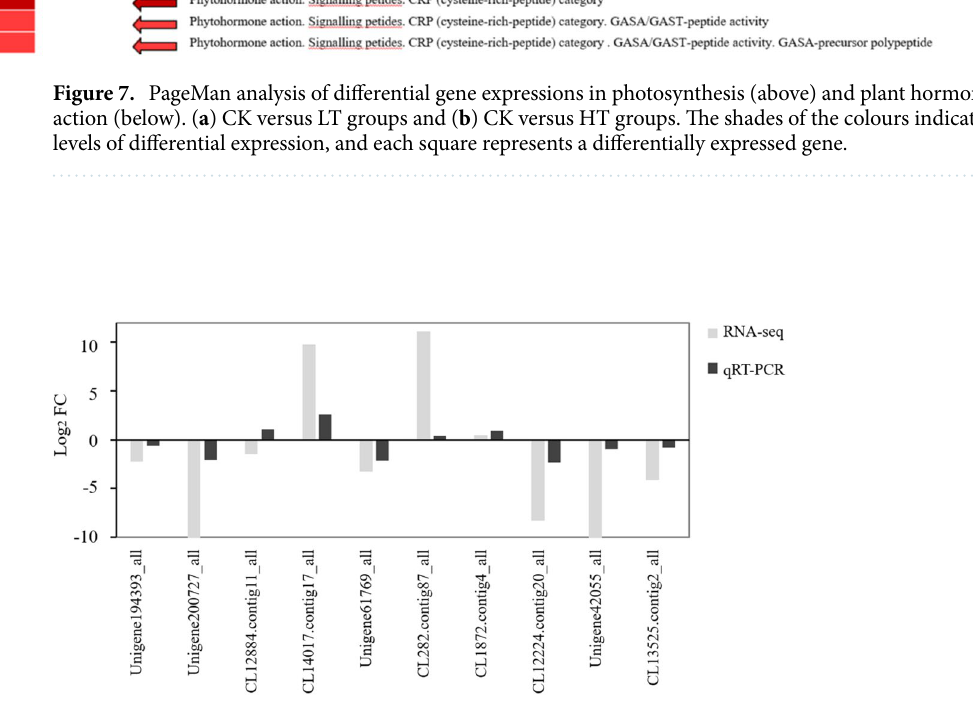
Figure 8. Comparisons of the qRT–PCR and RNA-seq